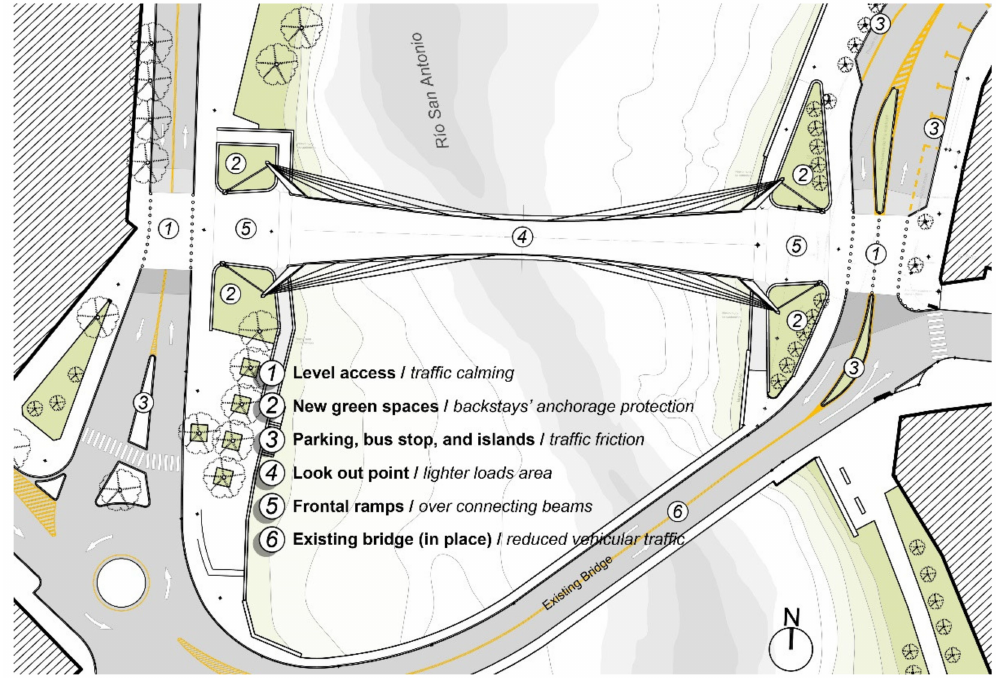
Figure 20. Ancillary works included traffic reconfiguration, parking, pedestrian crossings, public spaces, and